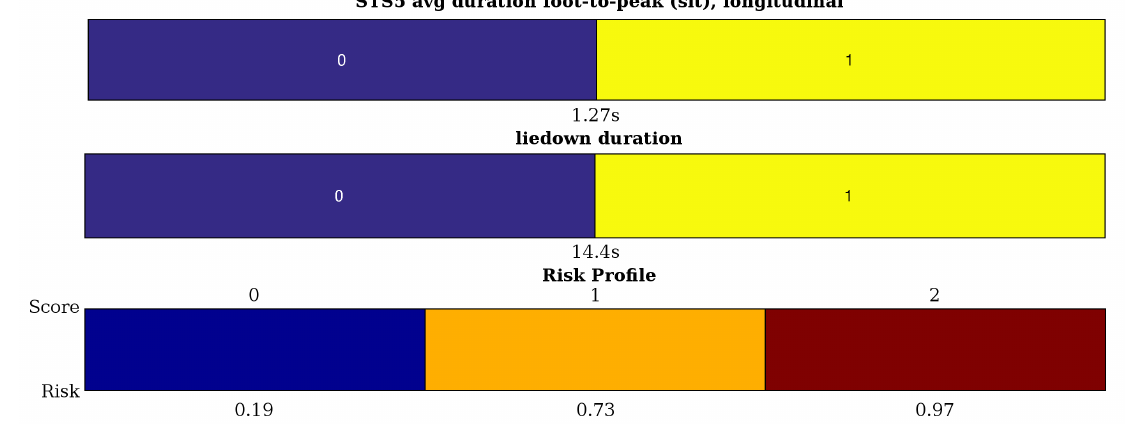
Figure 5. Example of a typical interpretable scoring system obtained by interval coded scoring (ICS). It shows the selected variables, their intervals with corresponding weights and the risk profile mapping the total score to a risk on decreased activity capacity ( ≥ 3 on the Bath Ankylosing Spondylitis Functional Index (BASFI) scale).